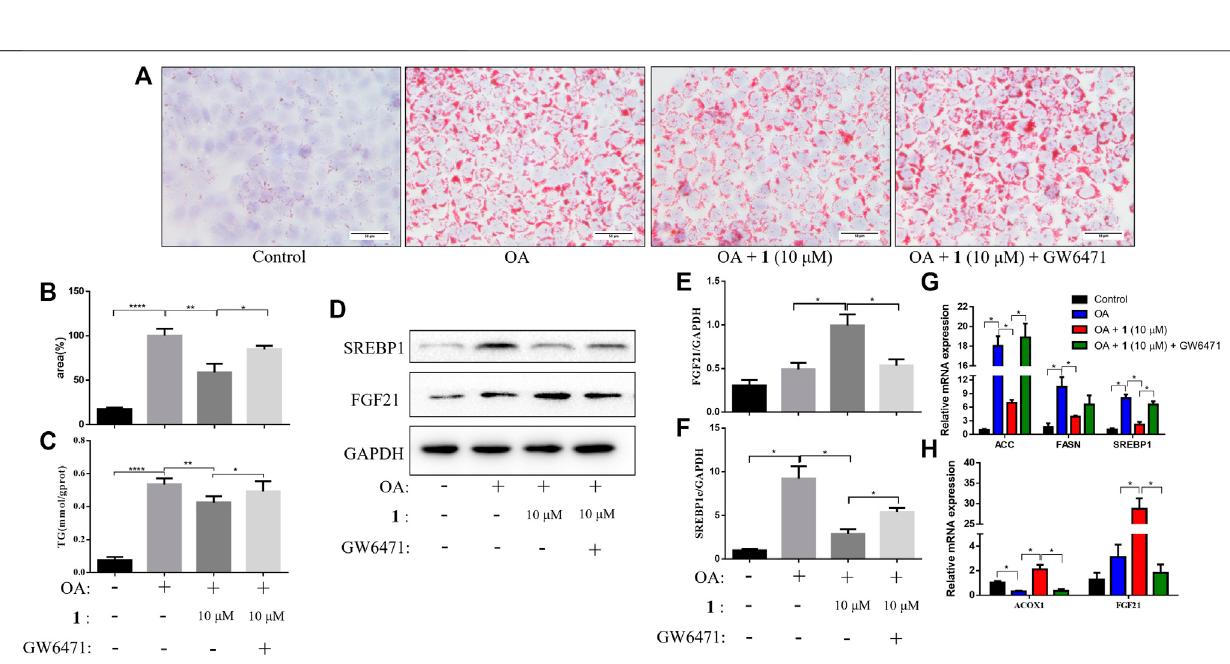
Frontiers in Pharmacology |